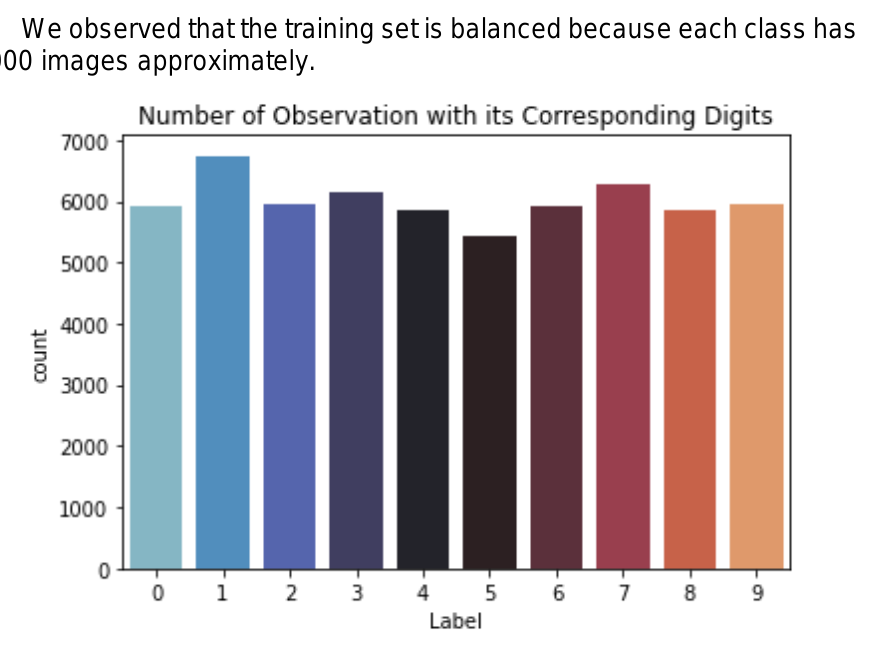
Figure 1 – Number of observations for each digit-training set Рис. 1 – Количество распознаваний по каждой цифре в учебном наборе Слика 1 – Број опсервација за сваку цифру у сету за увежбавање Table 3 – Number of observations in the MNIST training